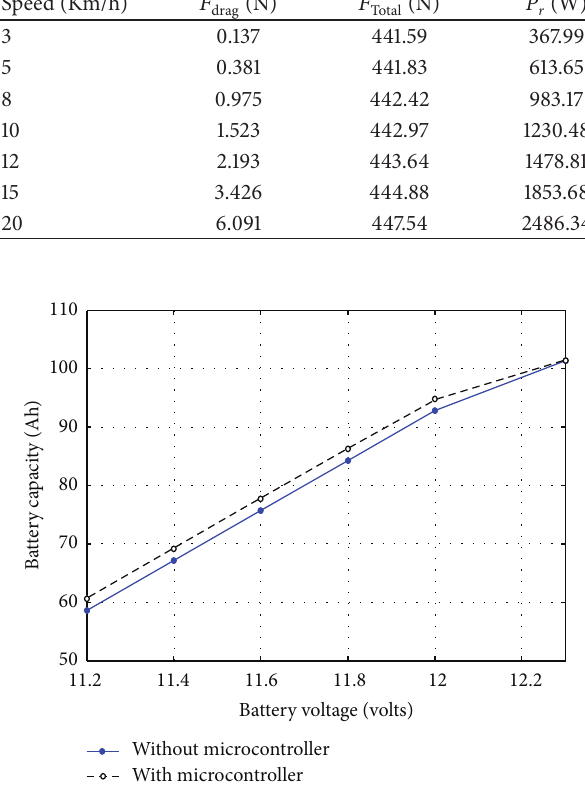
Figure9:Relationshipbetweenbatterycapacityandbatteryvoltage.